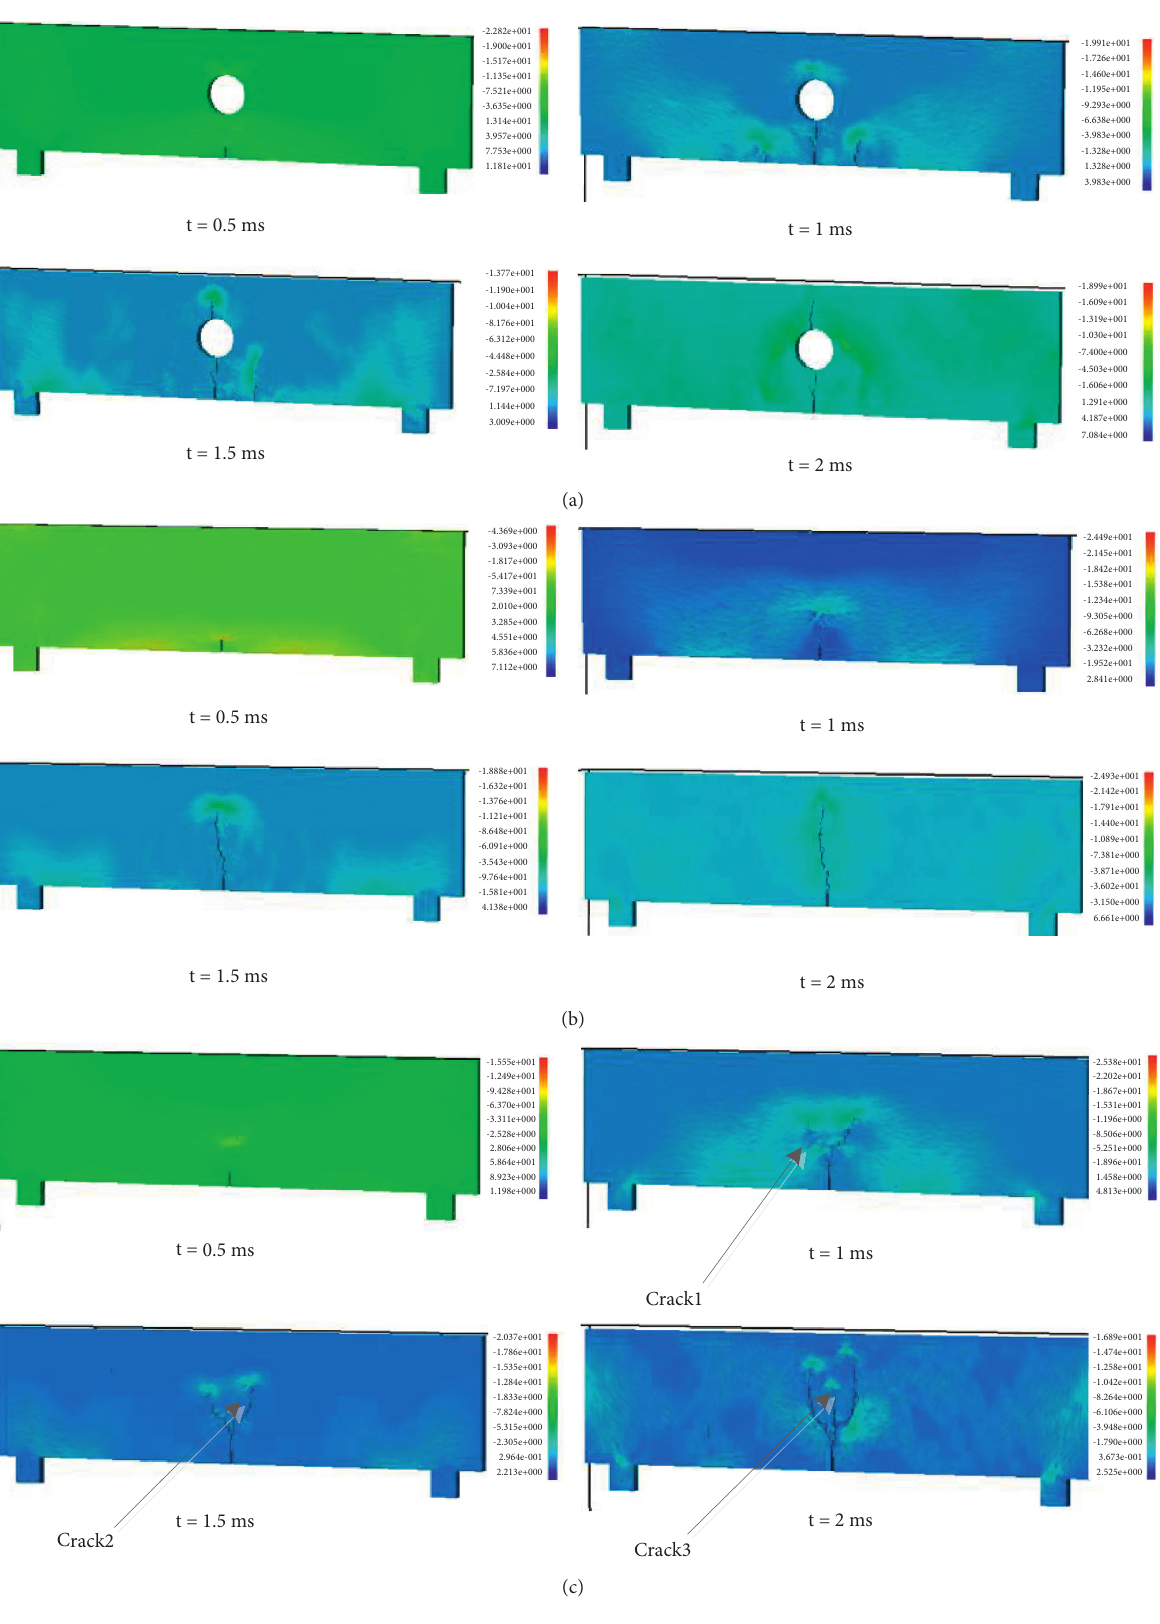
Figure 10: Diagrams of damage process and minimum principal stress diagram under dynamic load. (a) Model I; (b) model II; and (c) model